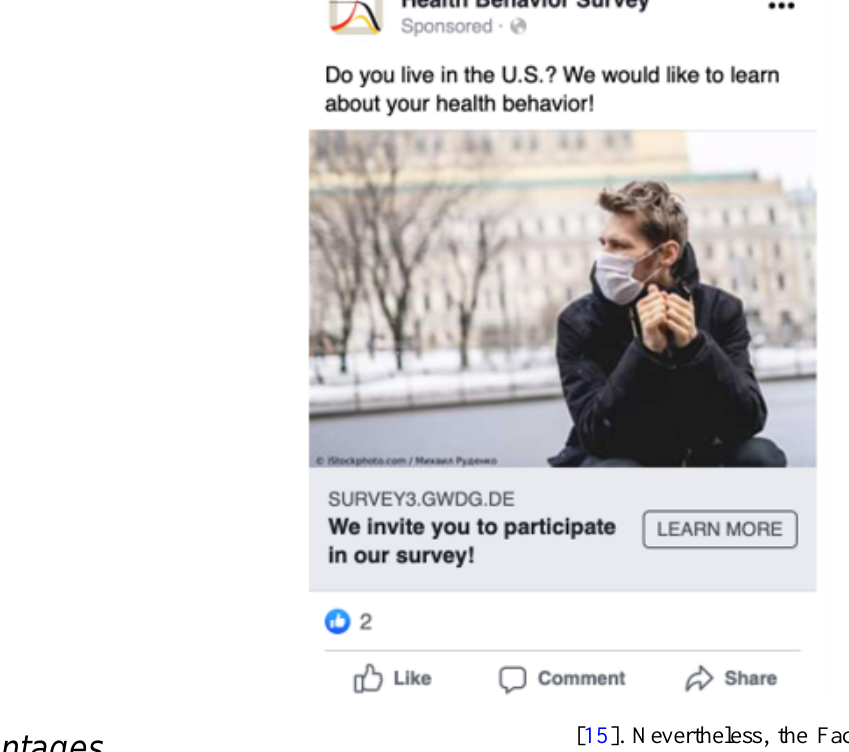
Figure 1. Example of an advertisement in the Facebook advertising campaign in the United